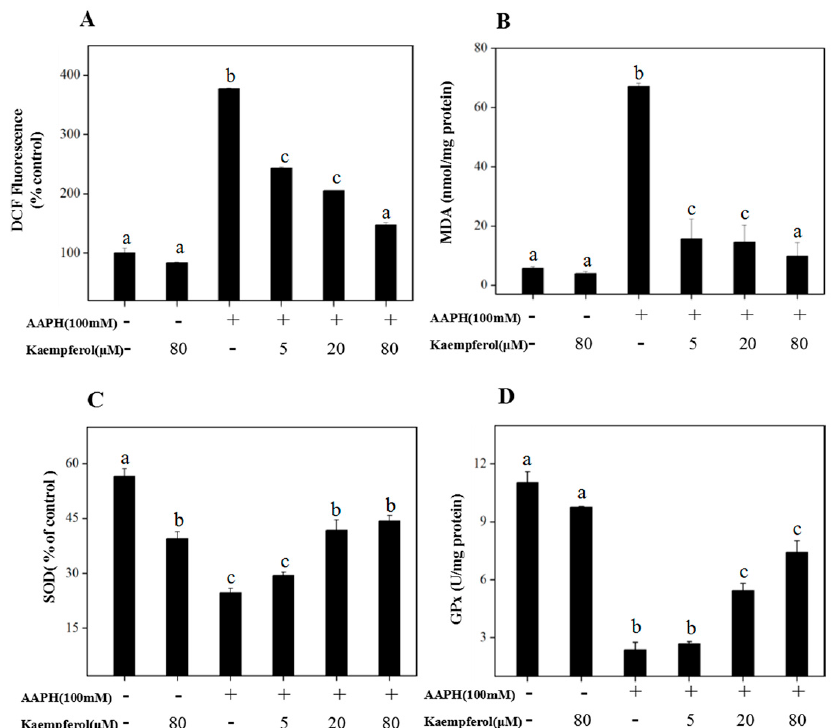
Figure 2. Protection of kaempferol against AAPH-induced oxidative damage. ( A ) Kaempferol inhibited AAPH-induced ROS generation in erythrocytes. ( B ) Kaempferol attenuated AAPH-induced MDA generation in erythrocytes. ( C ) Kaempferol enhanced AAPH-induced SOD activity in erythrocytes. ( D ) Kaempferol enhanced AAPH-induced GPx activity in erythrocytes. All data are expressed as means ± SD of triplicates. Means with different letters (a, b, c) are statistically different at p < 0.05 level.